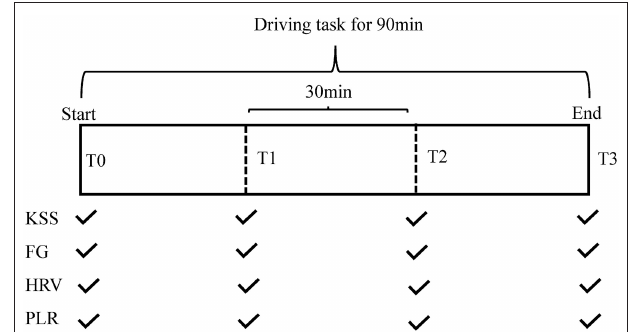
FIGURE 1 | Schematic diagram for the entire experimental framework. FG, fatigue grade; HRV, heart rate variability; KSS, Karolinska Sleepiness Scale; PLR, pupillary light